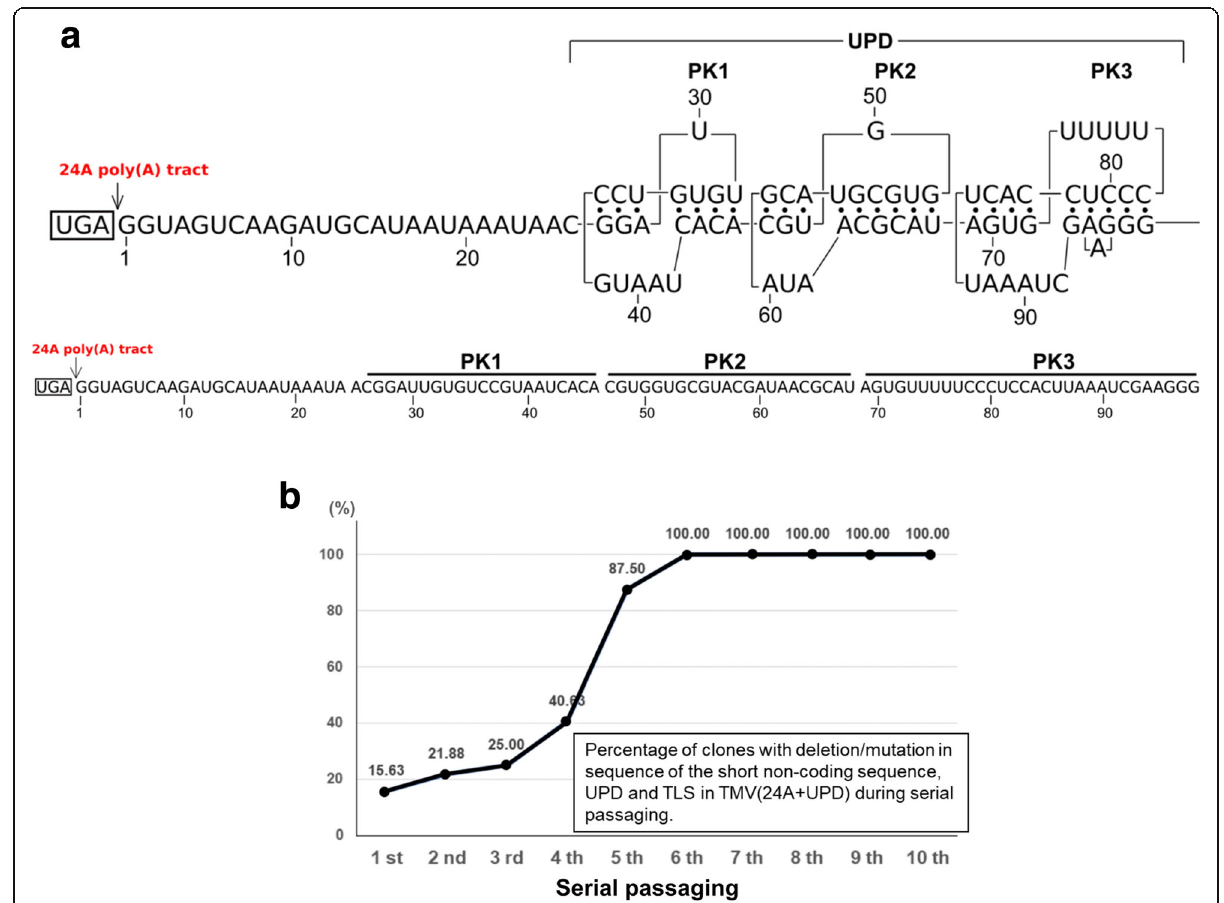
Fig. 5 a The nucleotide positions of the short non-coding sequence and pseudoknots (PKs) in the UPD were labeled. The stop codon of coat protein (CP) gene was boxed and the nucleotide downstream of 24 nt internal poly(A) tract was counted as the first nucleotide. b Percentage of clones with deletion/mutation in sequence of the short non-coding sequence, UPD and TLS in TMV (24A + UPD) during serial passaging